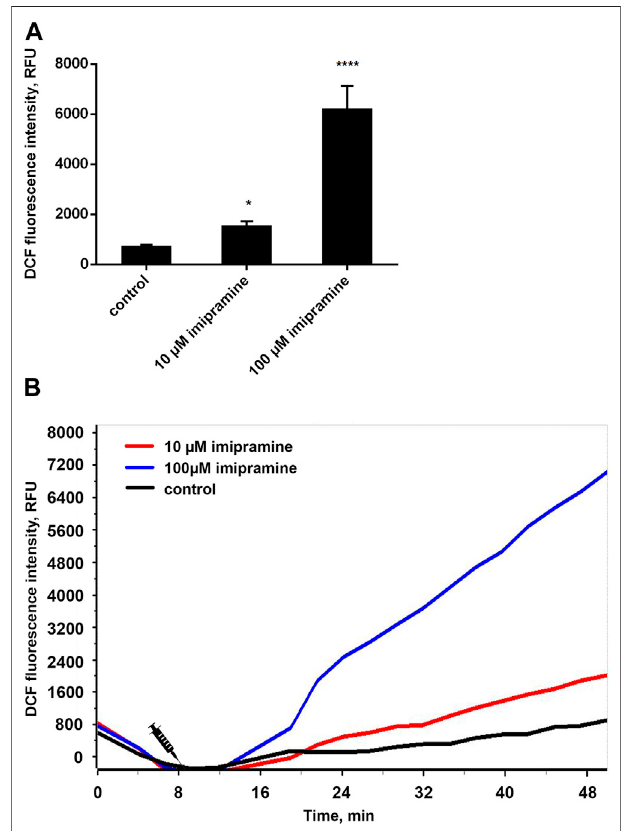
FIGURE 3 | Imipramine stimulated the ROS production by neutrophils during adhesion to fi bronectin. (A) H 2 DCF-DA-stained neutrophils were incubated in fi bronectin-coated 96-well plates for 60 min at 37 ° C in 5% CO 2 under control conditions and in the presence of 10 µM or 100 µM imipramine. Green DCF fl uorescence was measured for every 10 min throughouttheentireincubationperiod.Valuesrepresentthemeans ± SEMof DCF fl uorescence intensity (relative units) 30 min after adding stimuli from three independent experiments.* p < 0.05, **** p < 0.0001 compared with control as indicated by ordinary one-way ANOVA. (B) Exemplary kinetic curves show an increase of DCF fl uorescence, meaning an increase of intracellular ROS in